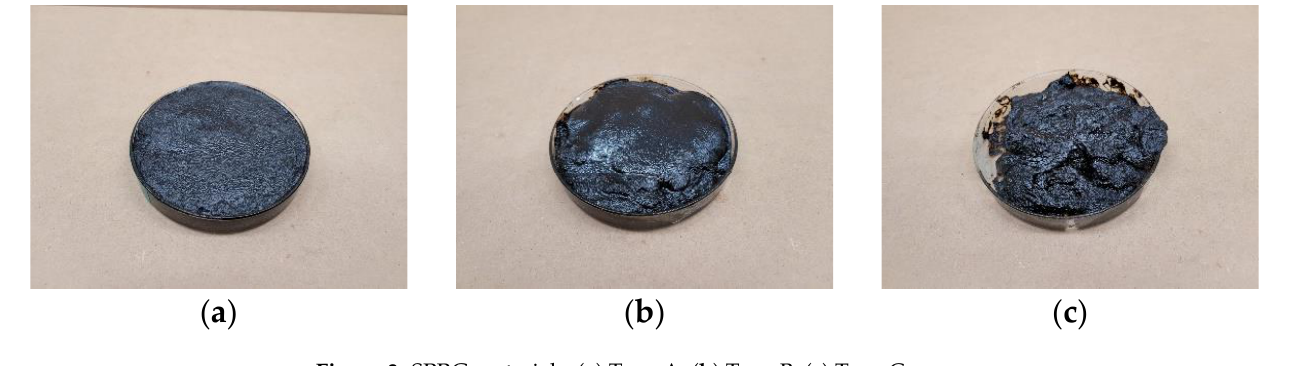
Figure 3. SPRG materials; ( a ) Type A; ( b ) Type B; ( c ) Type C.